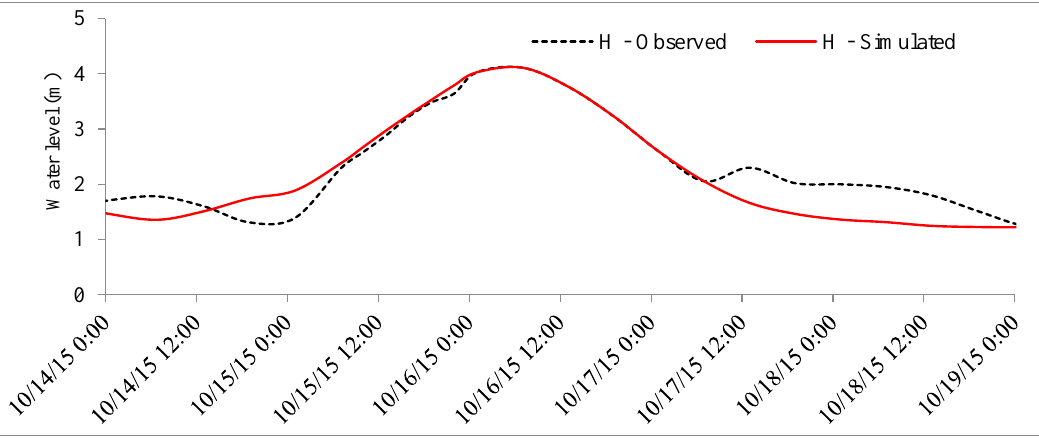
Figure 12. The validation water level at the Cau Lau hydrological station in the VGTB river basin during October 31–November 7, 2016 flood event. Figure 13. Location ( left ) and sample picture ( right ) of meteorological stations in the Vu Gia-Thu Bon river basin.